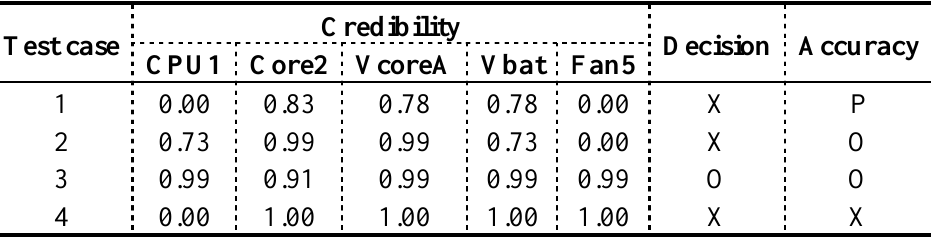
Table 7. Results of the mutual